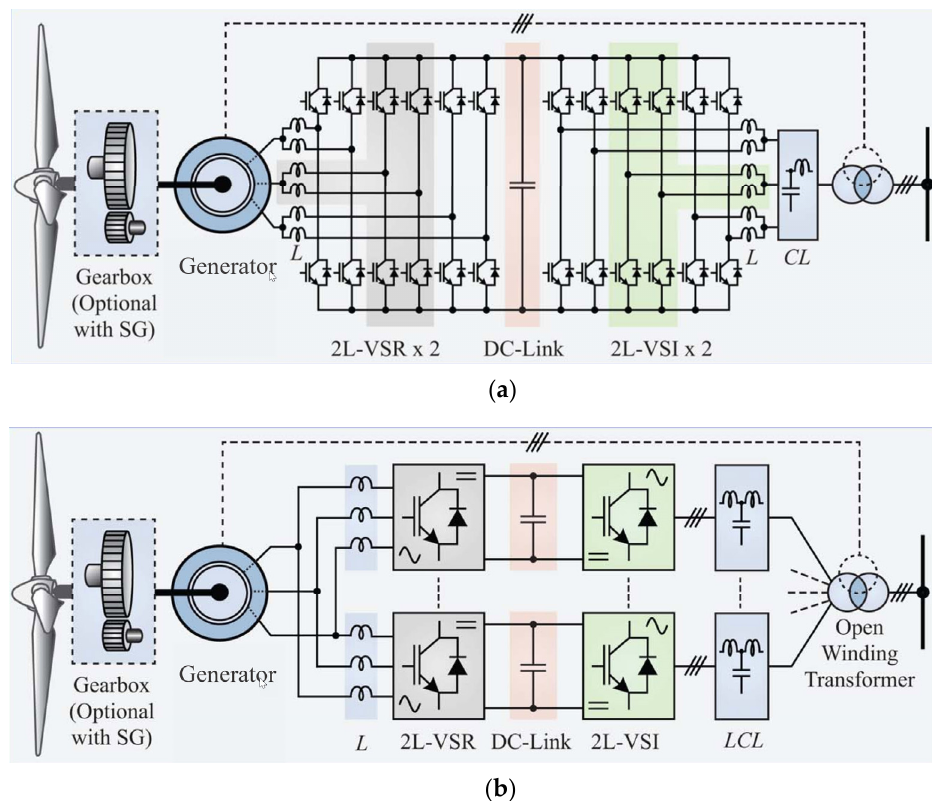
Figure 14. Multimegawatt wind turbine grid-connected systems with DC link, ( a ) two BTB-VSC connected in parallel, ( b ) Back-to-back voltage source converters with separate individual dc-links